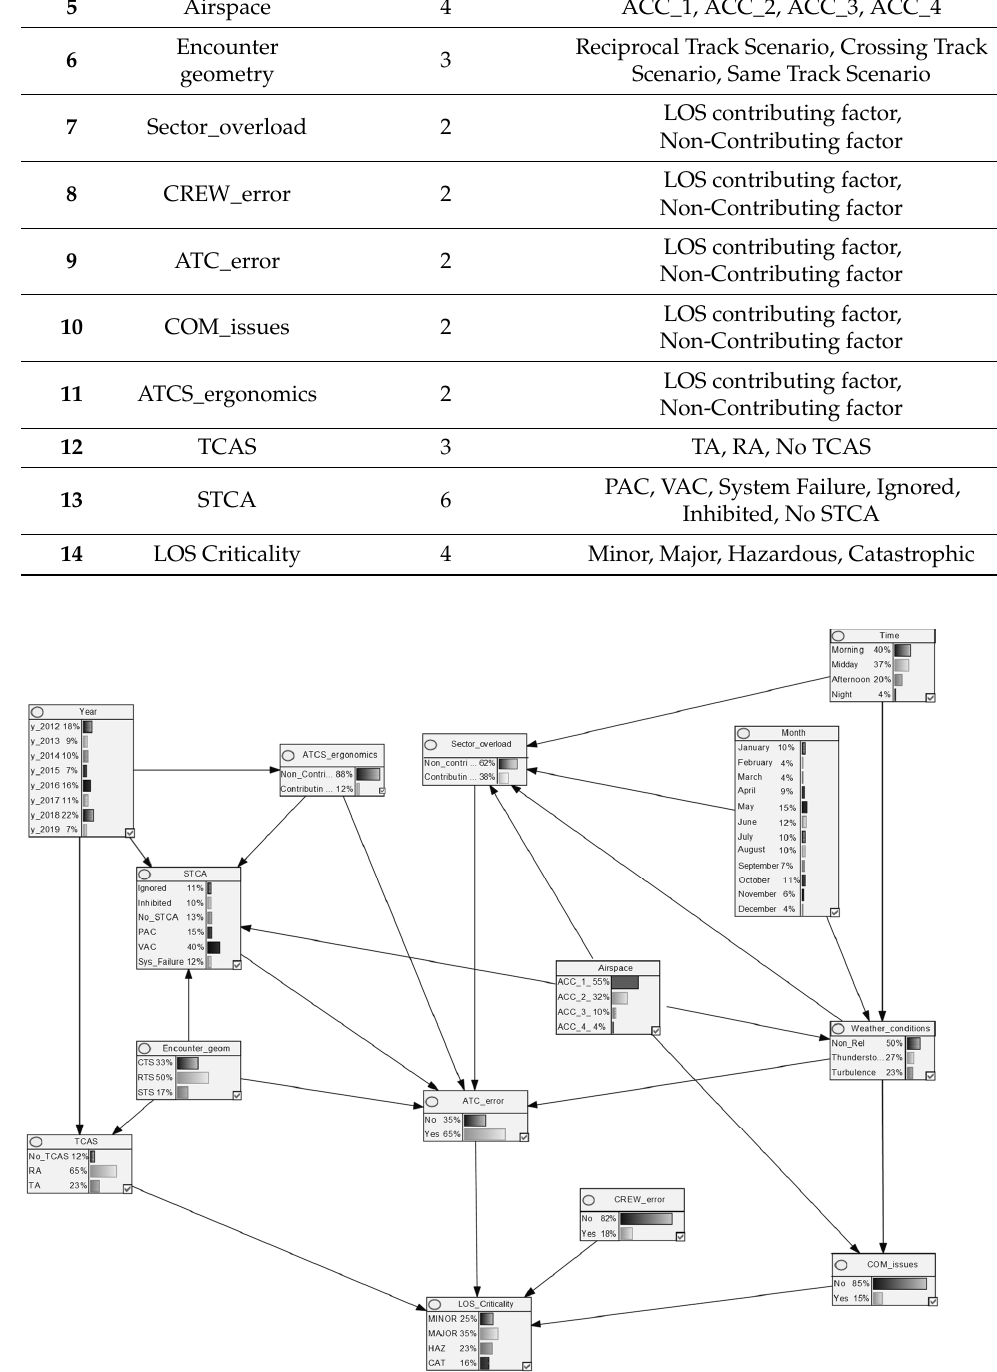
Figure 9 . Graphical representation of the BN considered. Figure 9. Graphical representation of the BN